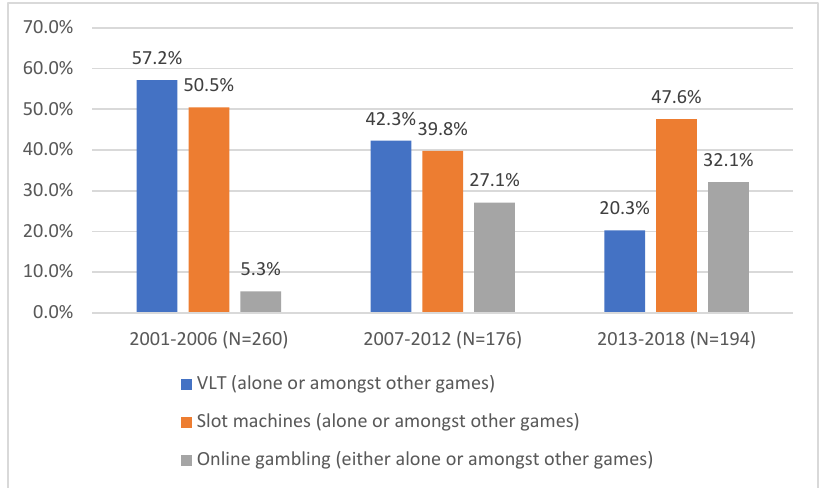
Figure 1. Evolution of referrals between 2001 and 2018 for patients playing VLT, slot machines or online gambling (either alone or amongst other games) ( n = 630). (Each new referral can play more